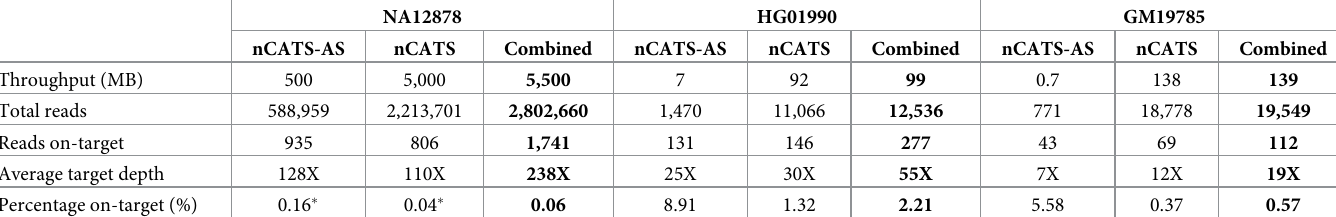
Table 1. General sequencing results of the nCATS-enriched NA12878, HG01990, and GM19785